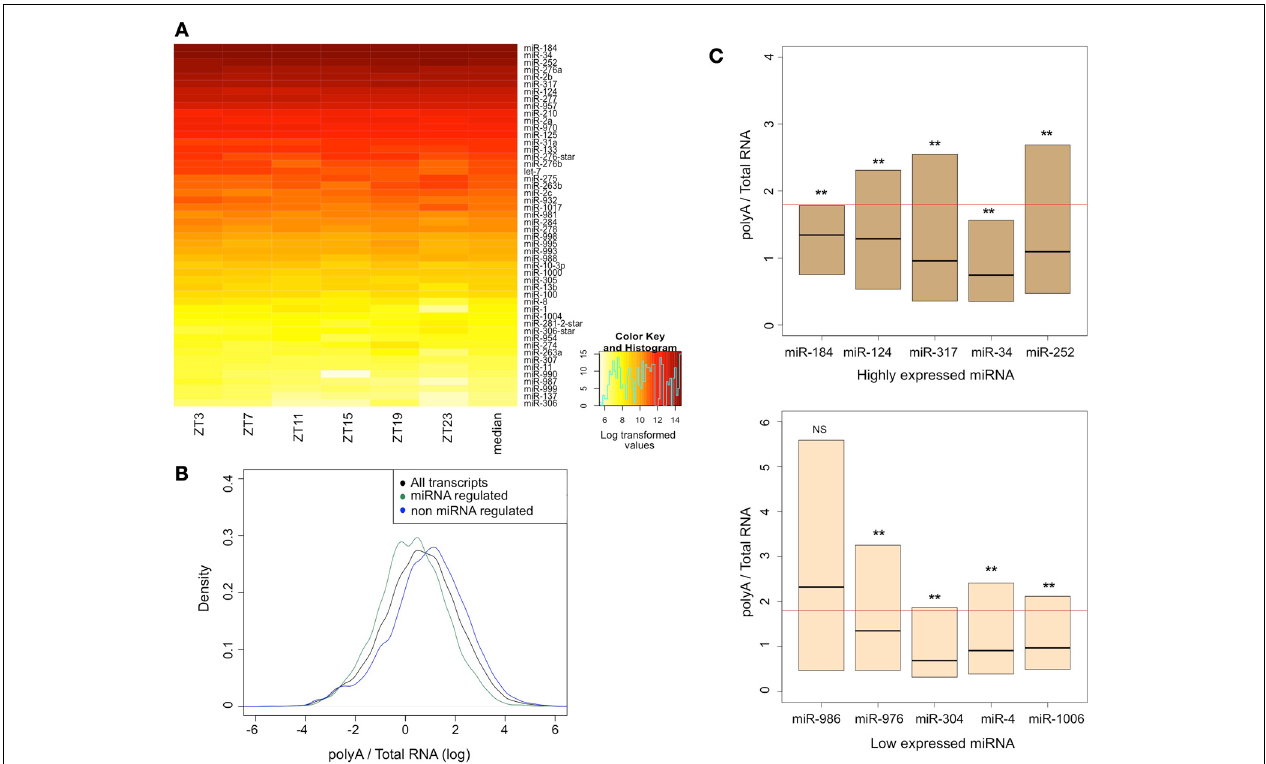
FIGURE 5 | Assessment of miRNA expression in the brain and the stability of their targets. (A) Heat-map representation of top 50 miRNA expressed in the Drosophila brain. Fly brains were collected across six time points of the circadian day (ZT, zeitgeber time). RNA was extracted and loaded to Affymetrix array chips. miRNA expression levels were averaged across the six time points for further analysis. (B) Density plot comparing the distribution of polyA/total-RNA values for all transcripts (black line; n = 32898) with those of miRNA-regulated genes (green line; n = 15206) and non miRNA-regulated genes (blue line;